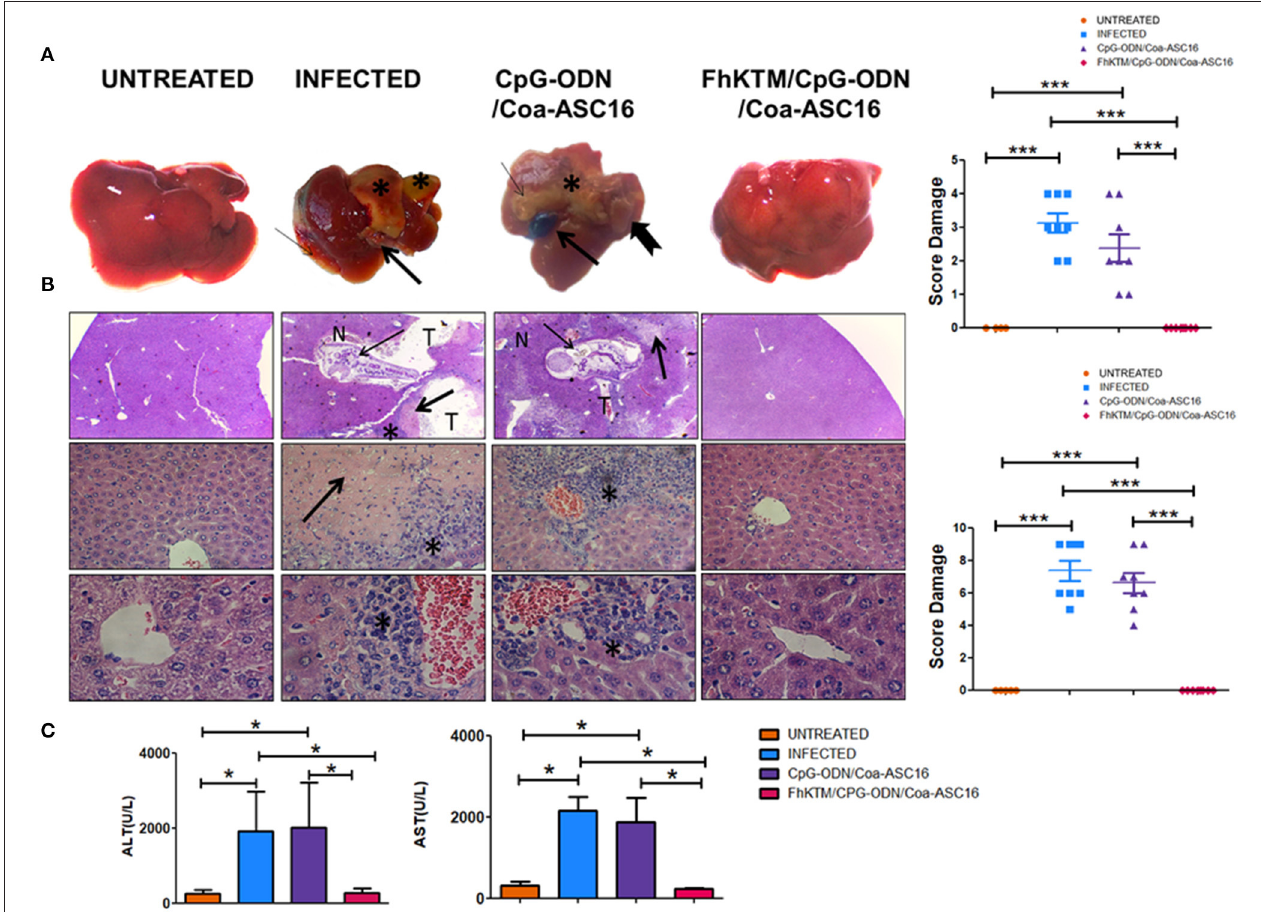
FIGURE 2 | FhKTM/CpG-ODN/Coa-ASC16 immunization in mice prevented liver damage caused by F. hepatica infection. Gross lesions of livers from mice after 24 days of the infection with F. hepatica or without infection. (A) Untreated: tissue from mice without treatment showed a standard architecture with no observed lesions. Infected: there are marked irregularities of capsule (thin arrow), changes in the tissue color (asterix) belonging to the growing fibrosis generated, and enlargement of bile ducts (thick arrow). CpG-ODN/Coa-ASC16: multiple foci of fibrosis (asterix), also enlargement, thickening, and color changes due to hemorrhages in the gallbladder (thick arrow) and the presence of worms on the liver surface (notched arrow). FhKTM/CpG-ODN/Coa-ASC16: the livers maintained a structure similar to the untreated control mice without visible lesions. Right, the score was assessed by the extensión of liver damaged (score range 0 to 5). The data shown are